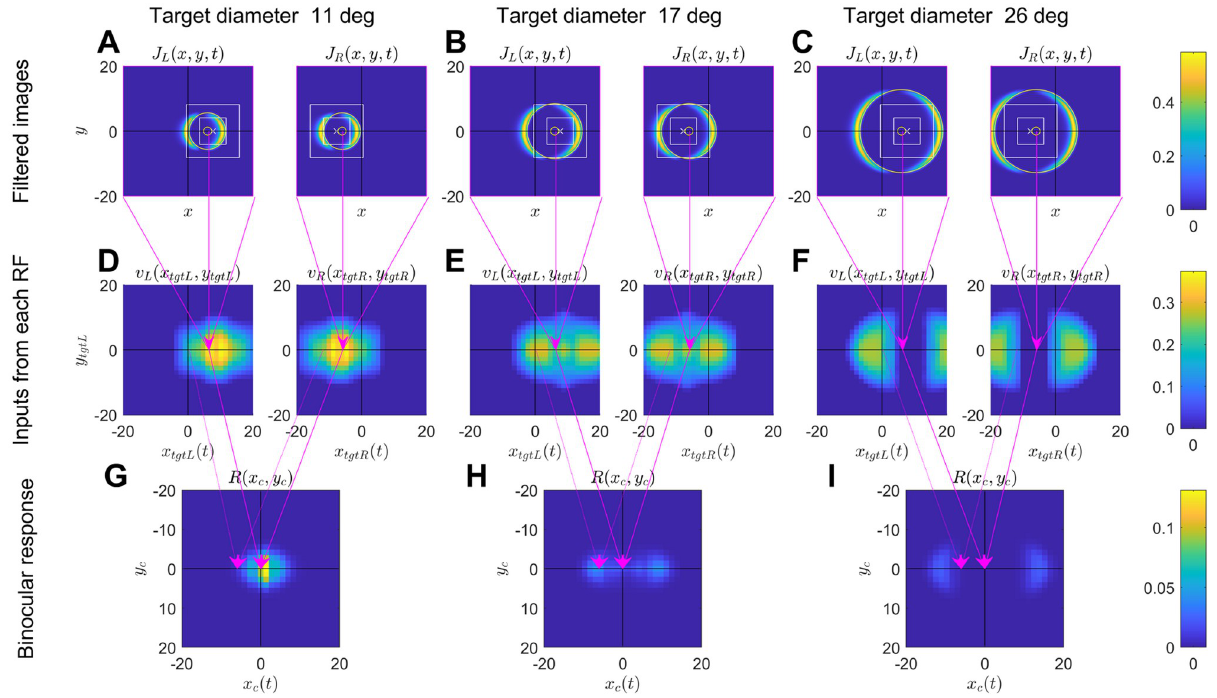
Fig 12. Responses of different model components to a horizontally-moving disk at a simulated distance of 2.5cm from the mantis. Left, middle, right columns are for a target of size 11.2˚, 16.9˚ and 25.5˚ as indicated. Sub-panels in the top two rows show left and right eyes. In all panels, axis coordinates are in degrees visual angle referred to the centre of the screen, i.e. x = 0, y = 0 corresponds to a location 10cm directly in front of the mantis. However, the interpretation of the axes differs in each row, as explained below. Top row (ABC): Snapshots of the filtered images J L , R ( x , y , t ), shown as a function of retinal location ( x , y ) for one particular time t . The axes are therefore simply retinal location. Pseudocolor represents the images reaching the sensor’s receptive fields, following lowpass spatial filtering, highpass temporal filtering and squaring in the early visual system. The receptive field excitatory region is shown superimposed for comparison. Each pixel represents the value of the filtered image at a particular location in the retina. These snapshots are for one particular time t and thus for one particular target position x ( t ), y ( t ) as the target moves across the screen. In this figure, tgt tgt the target was moving horizontally, so y tgt is in fact independent of time whereas x tgt = x 0 + Vt . The yellow circle marks where the center of the target is in that eye at the time shown. The white cross marks the center of the sensor receptive field in that eye; the inner white square marks the boundary of the central excitatory region, while the outer white square marks the boundary of the outer excitatory region. The surrounding inhibitory region extends beyond the range shown in each panel. Thus, parts of the filtered image falling outside the white squares have an inhibitory effect on the sensor. Middle row (DEF): Inputs to the binocular disparity sensor from the two eyes, v . The input from each eye is the inner product of the monocular L , R receptive field with the filtered image at that moment in time. It is here represented as a function of target position x tgt ( t ), y tgt . Since the target is moving horizontally across the screen from left to right, x is a function of time, whereas y is constant for a given trajectory. Each pixel-row in DEF therefore tgt tgt represents the time-course of the monocular input, v L , R ( t ), as the target moves from left to right over the screen, at the vertical location y tgt corresponding to the height of the pixel row. The axes therefore represent the current location of the target in the retina, and the panel as a whole does not represent an image, since different locations correspond to different times. The pink arrows mark the value of the monocular input in D for the filtered image shown in A. Bottom row (GHI): response of the disparity sensor, Eq 2. The axes are now the current visual direction of the moving binocular target, x ( t ) = 0.5( x ( t ) + x ( t )); x is again a function of time. Arrows from D to G show the target locations shown in the top row, A, and c tgtL tgtR c thus the response when the target crosses the midline, x c = 0. For comparison, dotted arrows show the response a little earlier when x c was − 6˚. The target’s direction in the visual field is x = ( x + x )/2 and y = ( y + y )/2. Since the target is moving horizontally, x is a function of time, but y c tgtL tgtR c tgtL tgtR c c is constant for a given